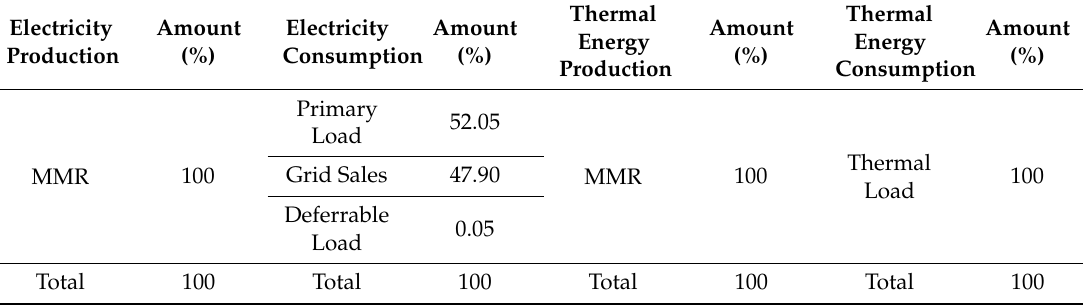
Table 14. Energy production and consumption scenario of off-grid mode for the first year of project life (case-04).